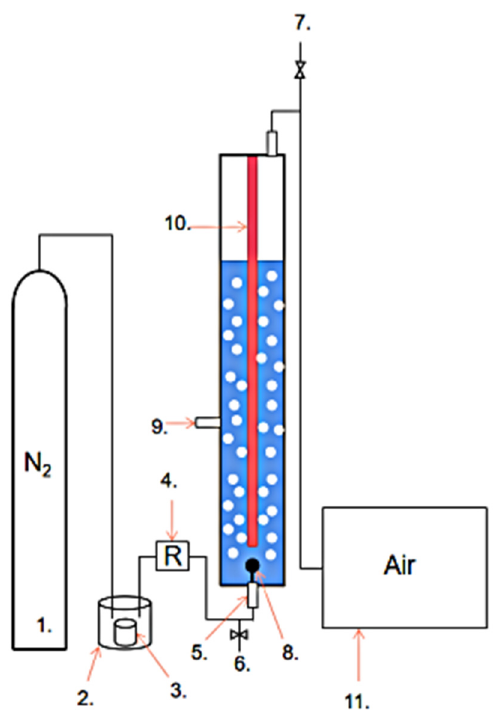
Figure 1. Device flow chart. 1. Nitrogen gas bottle 2. Wash bottle 3. Styrene vessel 4. Electron flowmeter 5. Air inlet 6. Front gas sampling port; 7. Back-end gas sampling port 8. Aerated stone 9. Liquid sampling port 10. Diving UV lamp 11. Gas chromatograph